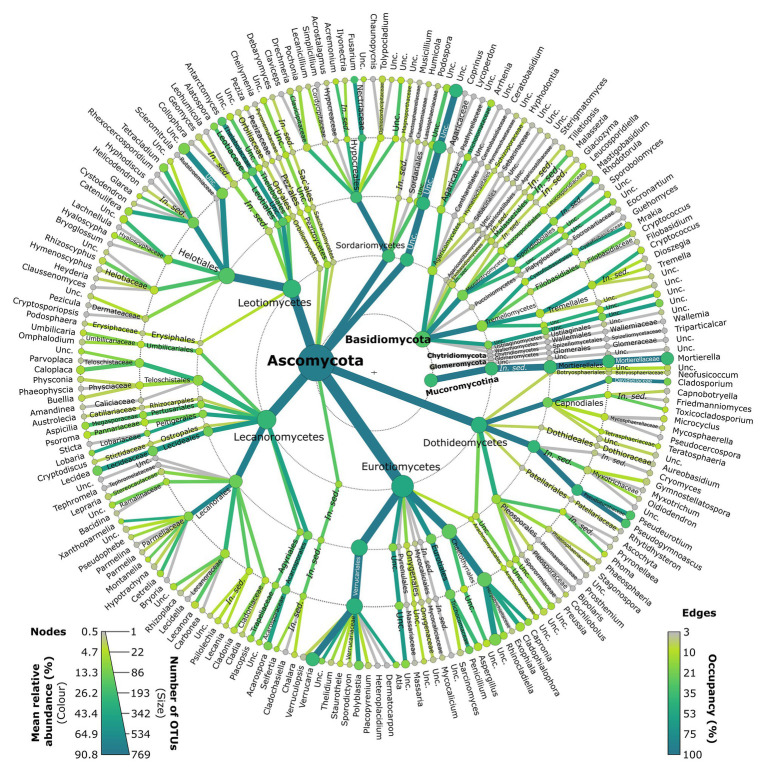
Metacoder representation of the taxonomic composition of the Antarctic fellfield soil fungal community. Nodes and branches are coloured by the total number of reads assigned to them, and are sized by numbers of OTUs. Edge colours represent occupancy. Unc., unclassified.